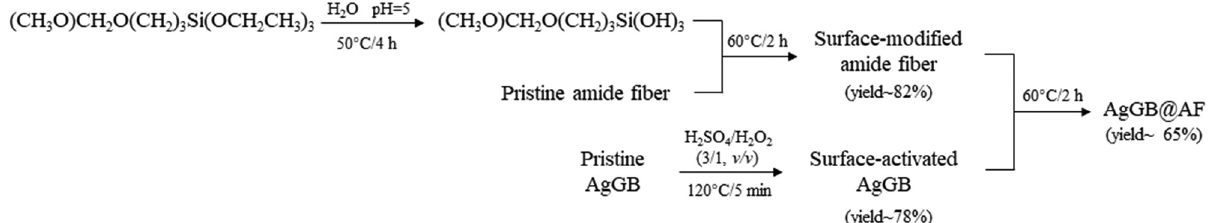
Figure 1: Reaction route of preparing